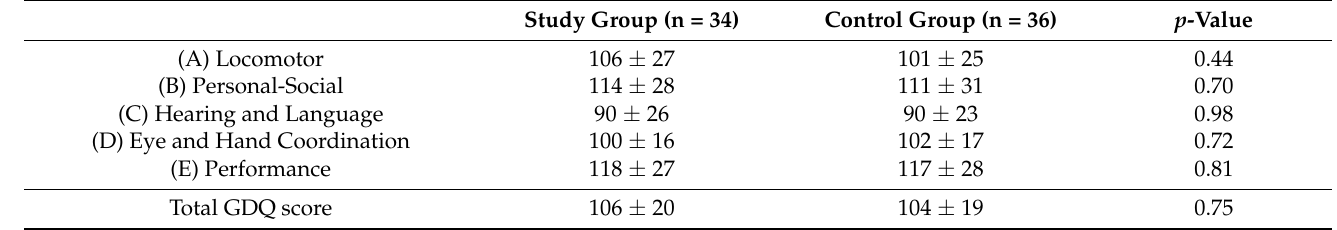
Table 6. Total Griffith’s Developmental Quotient (GDQ) and Griffith’s subscale scores in the two groups at 24 months of corrected